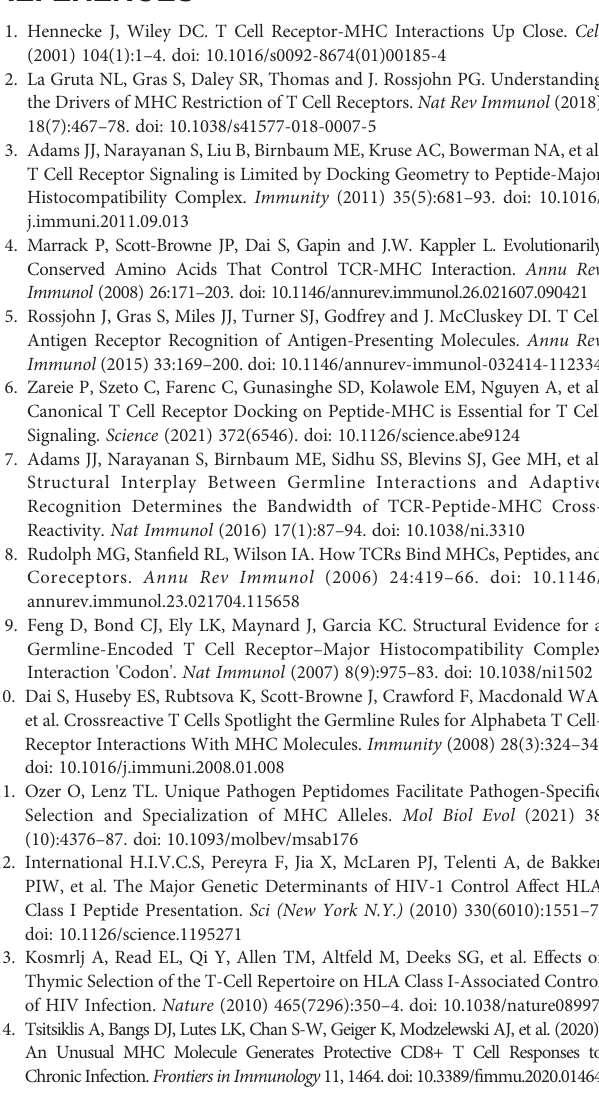
Supplementary Figure 5 | Docking angles of V b 2 and V b 8 containing TCRs to pMHC. TCR3d_DA = Conventional docking angle; TCR3d_IA = Conventional incident angle (obtained from the TCR3d database: https://tcr3d.ibbr.umd.edu/); TRA = Angle formed from the TRA plane modeled by the TRA VJ center of mass and regression of CDR1-3a; TRA_germ = Angle formed from the TRA plane modeled by the TRA VJ center of mass and regression of only CDR1a and CDR2a; TRB = Angle formed from the TRB plane modeled by the TRB VDJ center of mass and regression of CDR1-3b; TRB_germ = Angle formed from the TRB plane modeled by the TRB VDJ center of mass and regression of only CDR1b and CDR2b; TCR = Angle formed from the TCR plane modeled by the TCR V(D)J center of mass and regression of CDR1-3a and CDR1-3b; TCR_germ = Angle formed from the TCR plane modeled by the TCR V(D)J center of mass and regression of only CDR1a, CDR2a, CDR1b, and CDR2b. V b 2 (PDB IDs: 1FO0, 1KJ2, 1NAM, 2OL3, 6DFS, 6X31) are represented in orange and V b 8 (PDB IDs: 3C5Z, 3C6L, 3RDT, 3RGV, 4N5E, 6DFW) TCRs are represented in cyan. Interaction angles between with pMHC between the Vb2 and Vb8 TCRs were compared, and signi fi cance was determined using Mann-Whitney U tests with Bonferroni multiple testing corrections. * denotes an adjusted p-value < 0.05 and ns denotes not signi fi